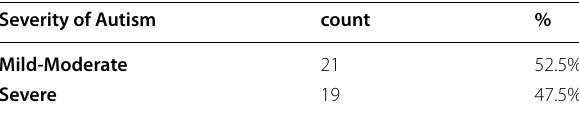
Table 3 Severity of autism according to Childhood Autism Rating Scale scores in the patients’